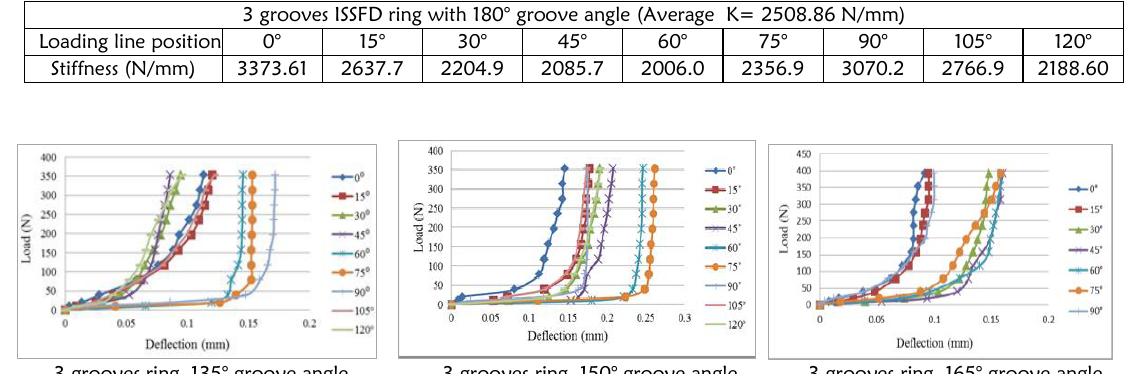
Table 1: Stiffness values for 3- grooves ISSFD ring with 180° Groove Angle